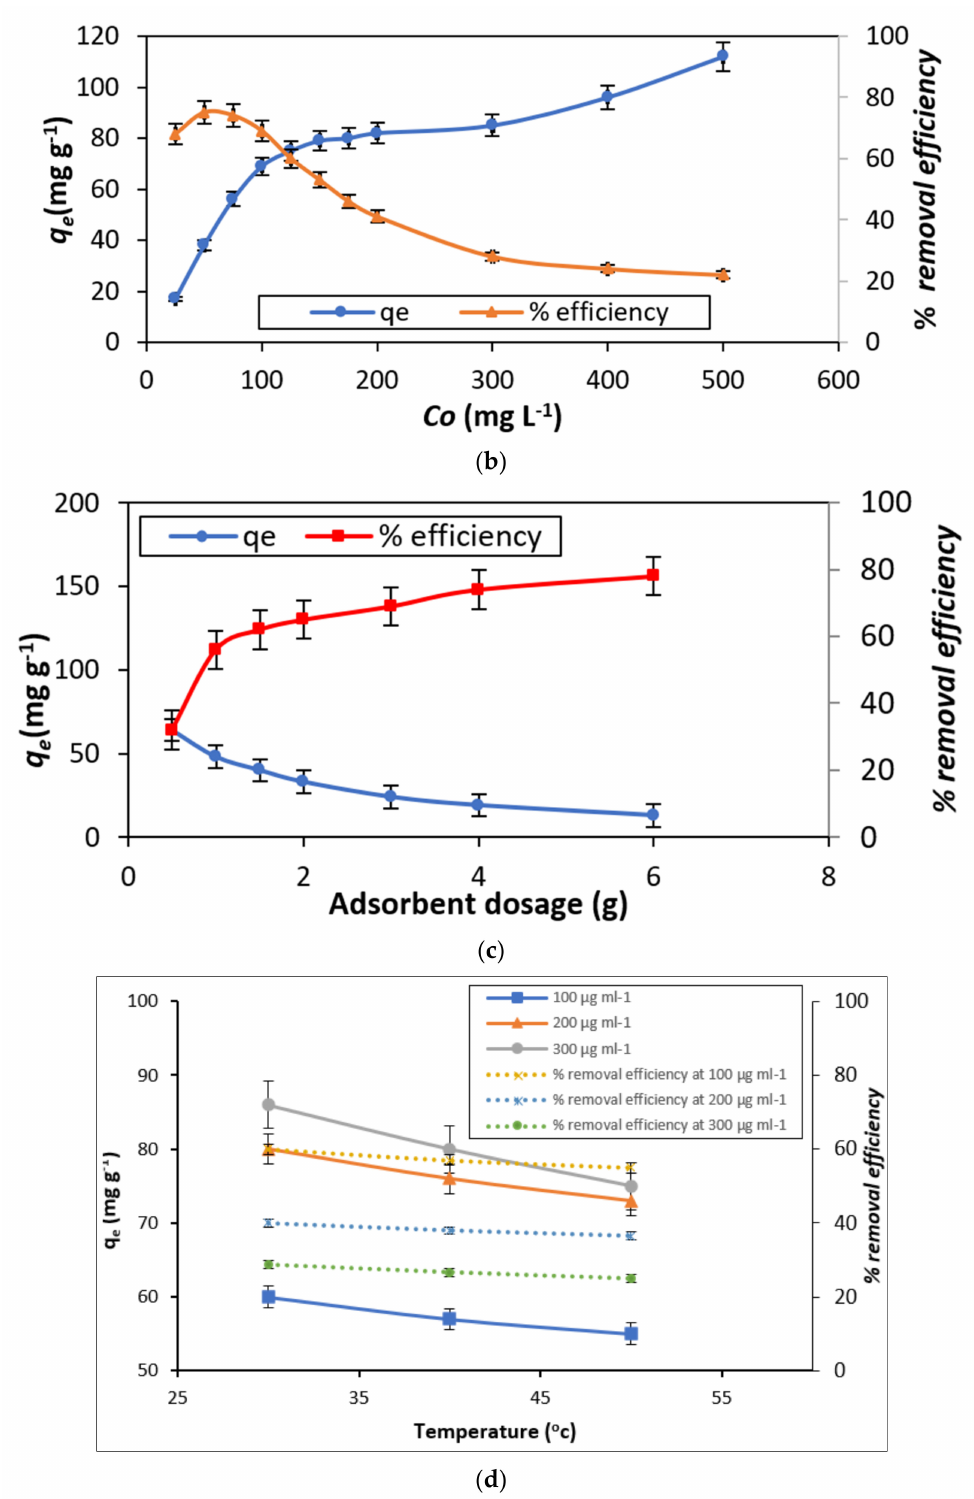
Figure 5. Adsorption capacity and percentage of dye removal efficiency: ( a ) Effect of pH,( b ) Effect of initial concentration of DB15 (adsorbate), ( c ) Effect of HNT (adsorbent) dosage, and ( d ) Effect of